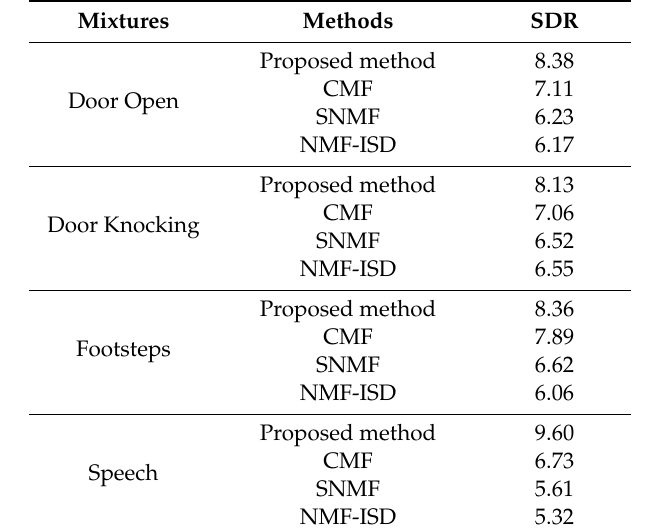
Table 2. Comparison of average SDR and SIR performance on three types of mixtures between SCICA, NMF-ISD, SNMF, CMF, and the proposed